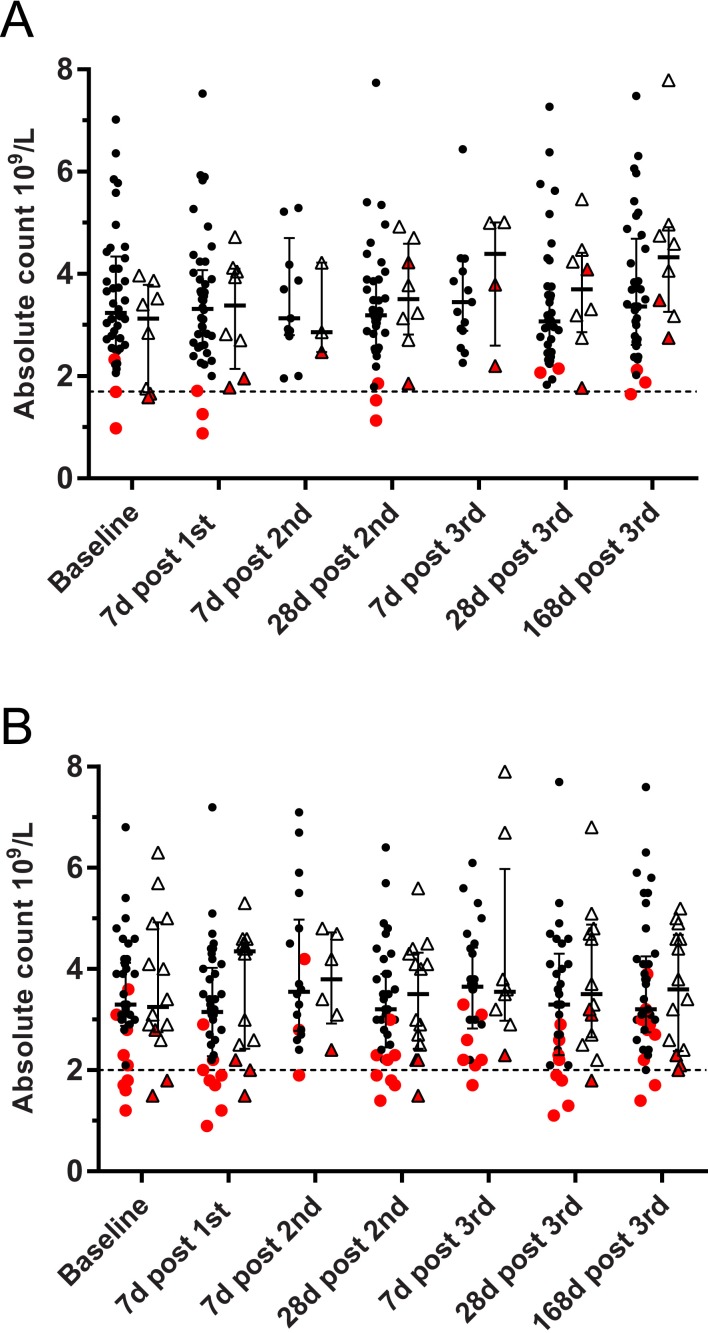
Absolute neutrophil count at different time points after vaccination with three doses of either 1790GAHB or placebo at 0, 1, and 2 months.(A) H03_01TP study. (B) H03_02TP study. Red dots indicate subjects who had an absolute neutrophil count less than laboratory normal range on at least one time point after vaccination. Baseline data are collected during the screening of volunteers. Bars indicate median and interquartile range. At each time point, dots relating to ANC in vaccinees are on the left hand side and dots relating to ANC in placebo recipients are on the right hand side.